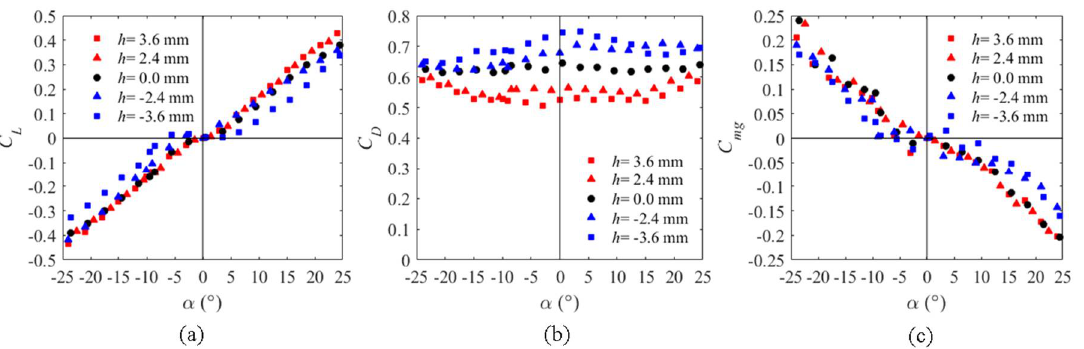
Figure 4. Aerodynamic characteristics for cambered models. ( a ) Lift coefficient; ( b ) Drag coefficient; ( c ) Pitching moment